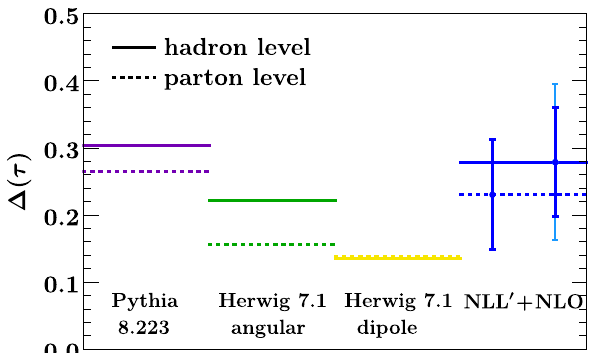
Fig. 5 Analogous to Fig. 1 but without a cut on τ